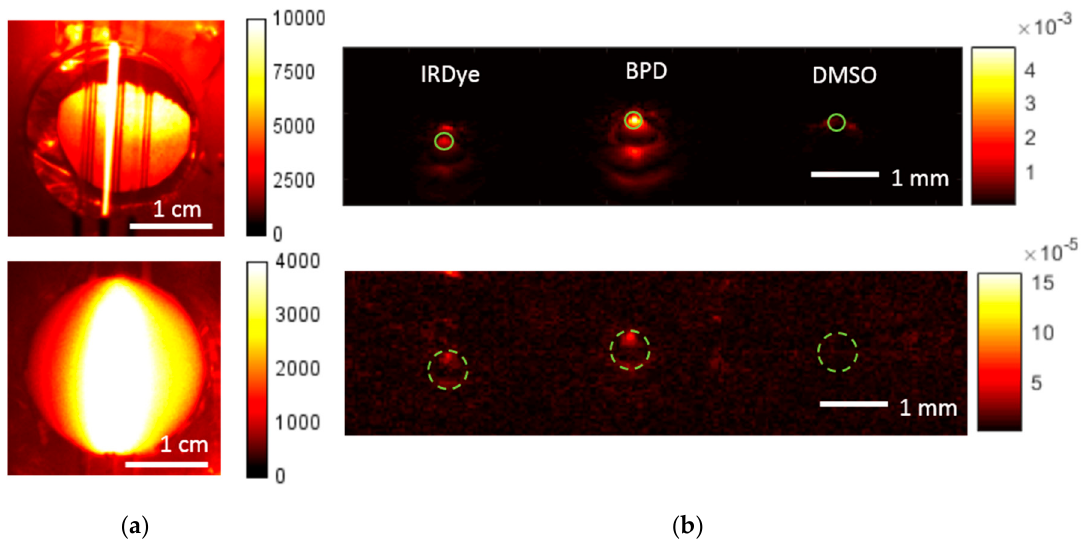
Figure 5. Fluorescence images ( a ) and reconstructed optoacoustic B-scans ( b ) of the water phantom (top) and agar mixture phantom (bottom) for the excitation wavelength of 690 nm. Solid green circles represent the areas of averaging for the contrast calculation. Dashed green lines depict the position of tubes filled with dyes.